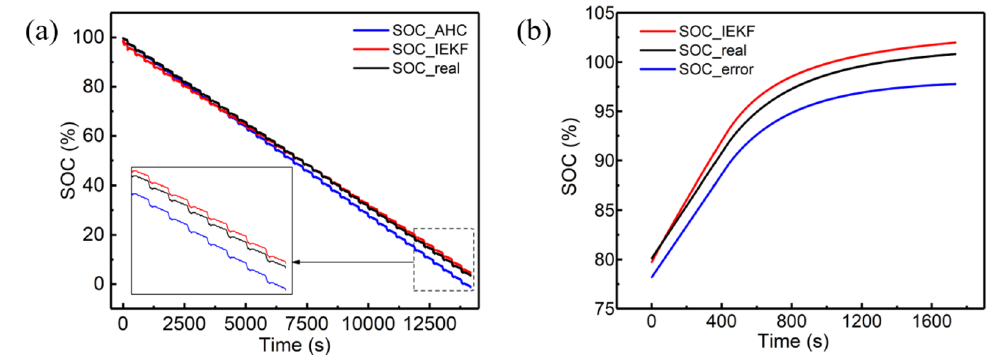
Figure 11. Results of robustness validation: (a) the result of mismatched capacity, (b) the result of deviation for current sensor.